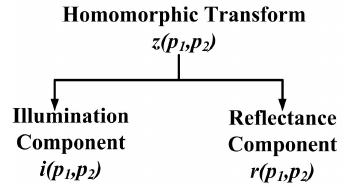
Figure 1: Illumination and Reflectance Component of an